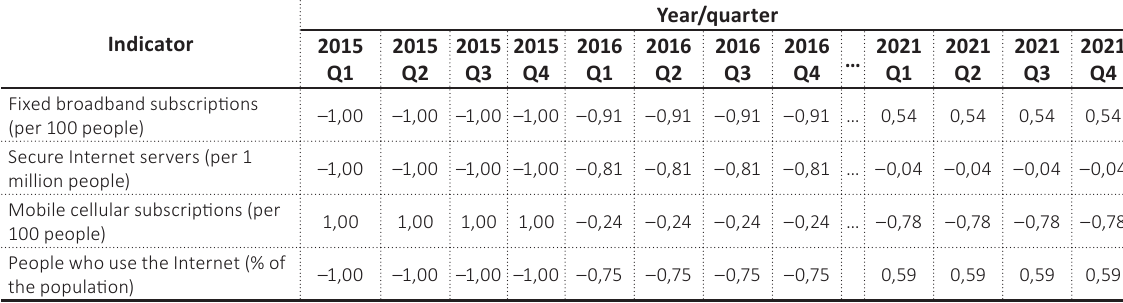
Table А10. Normalized values of general digitization indicators Indicator